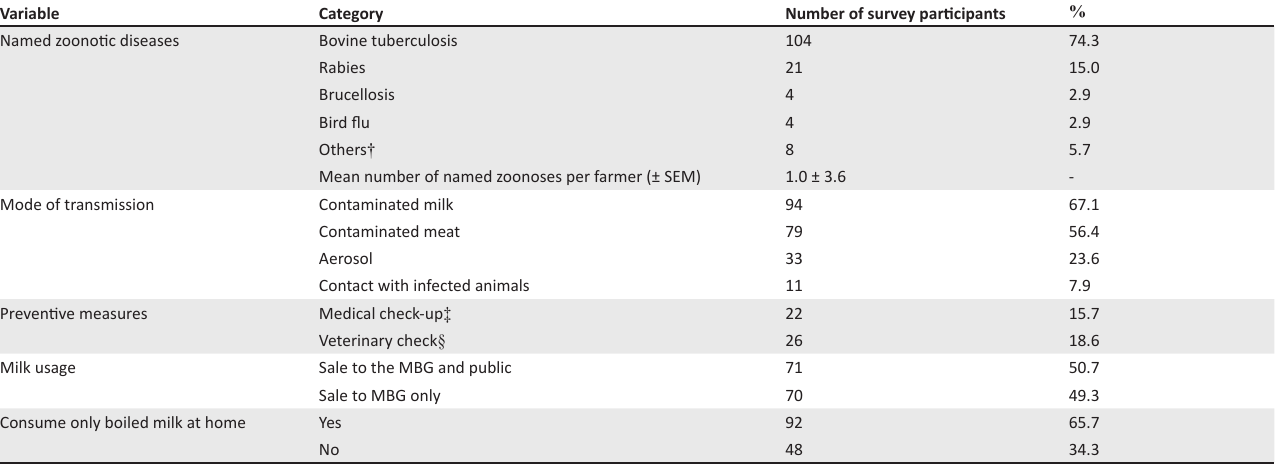
TABLE 1: Named zoonotic diseases, possible means of transmission and preventative measures in smallholder dairy farms Variable Category Number of survey participants % Named zoonotic diseases